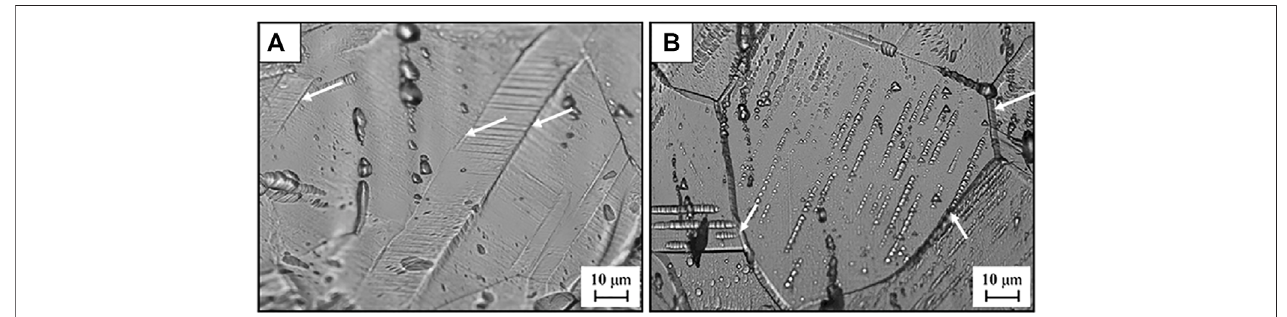
FIGURE 8 | The morphologies of the fatigue bands across the boundaries of (A) SBs and (B)